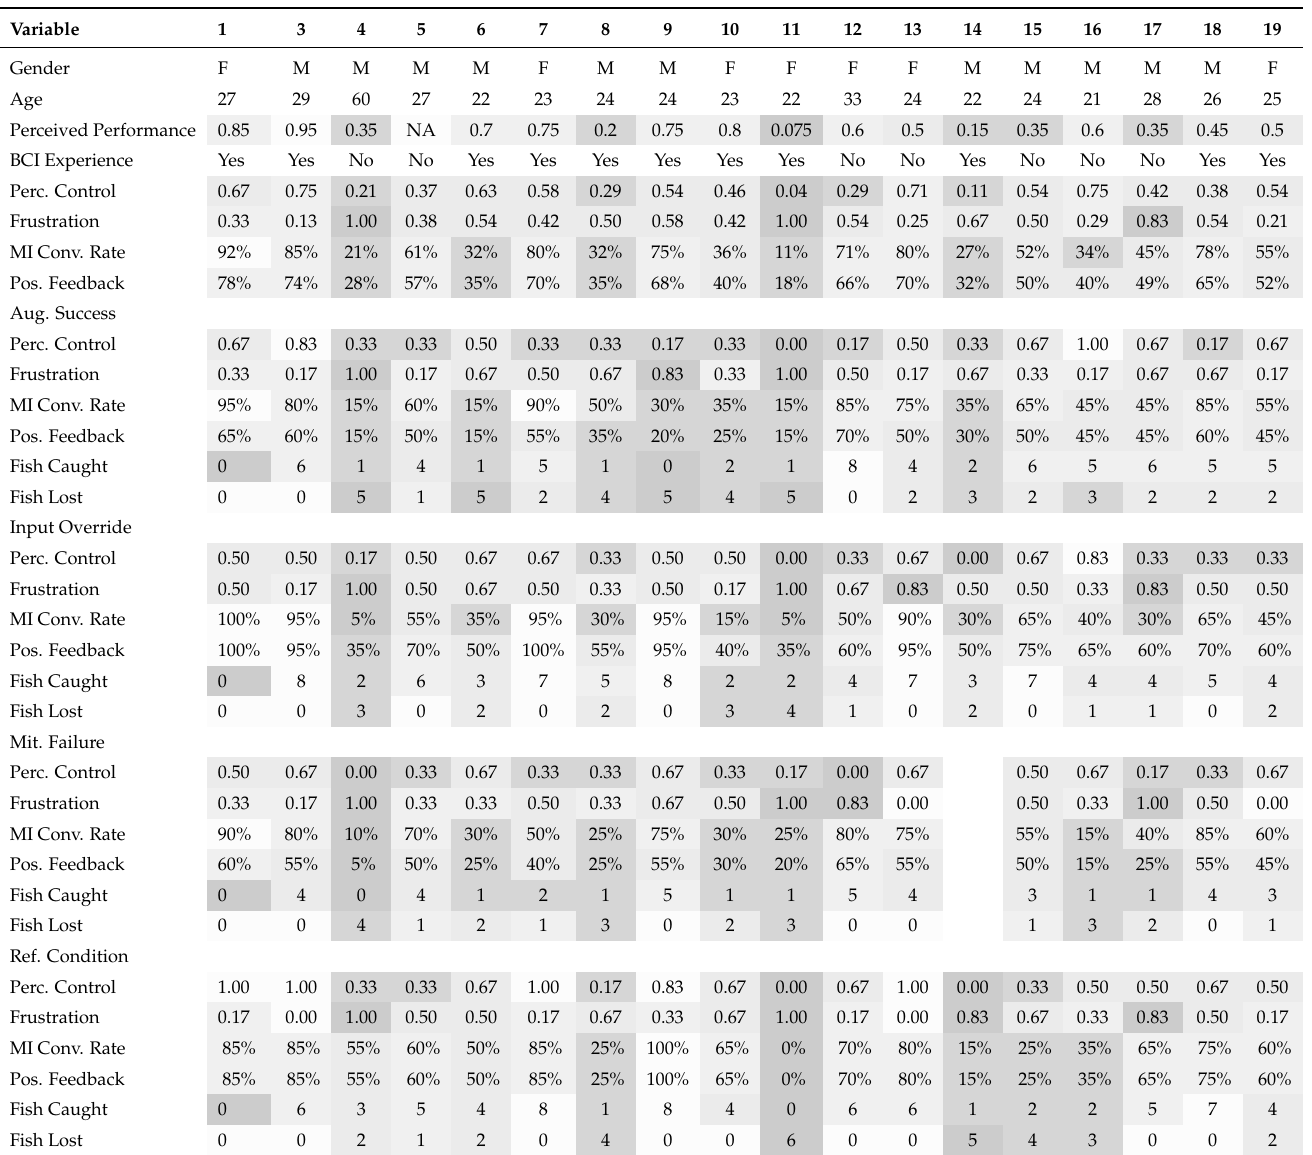
Table 3. Participant demographics, individual scores per condition (Likert scales of perceived control and frustration), MI conversion rate (% of MI events, which resulted in positive outcomes), and positive feedback (% of trials, which delivered positive feedback). Gray denotes high frustration, low perceived control, low MI conversion rate, or low positive